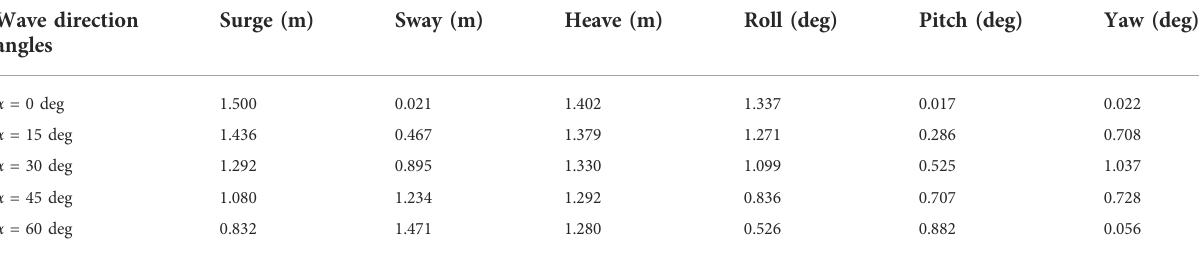
TABLE 4 Motion amplitudes of fl oating offshore wind turbine under different wave direction angles. Wave direction